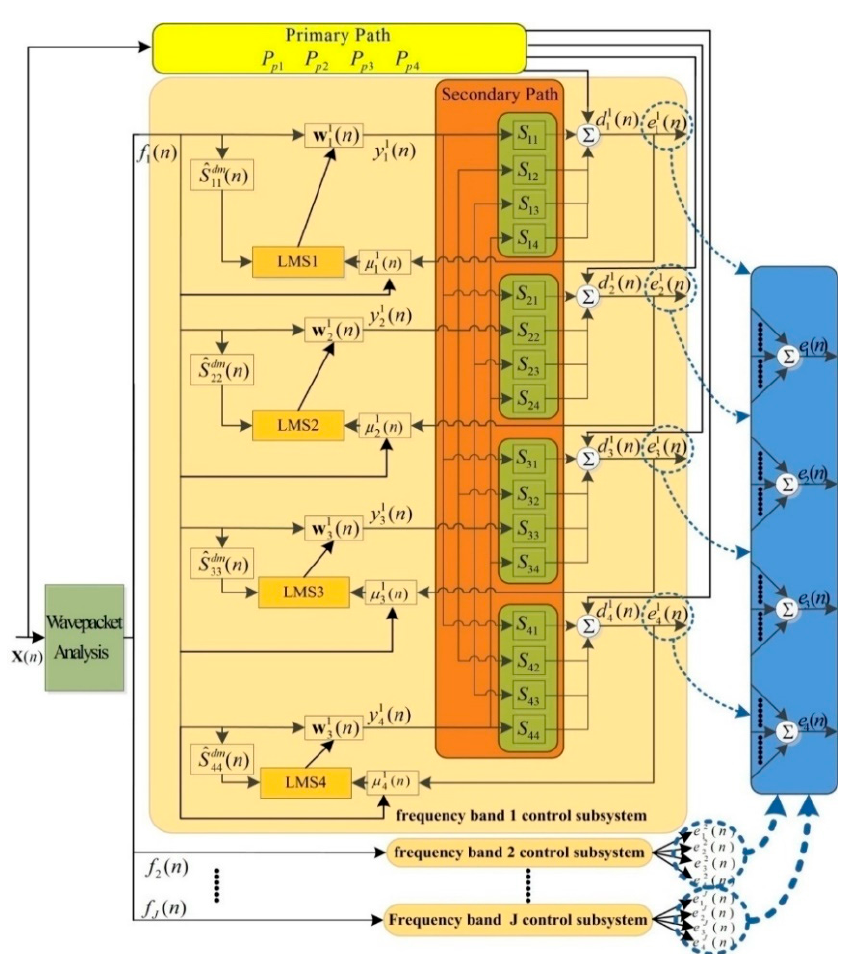
Figure 3. The structure diagram of WPTDDM-FxLMS algorithm for the MIMO system.